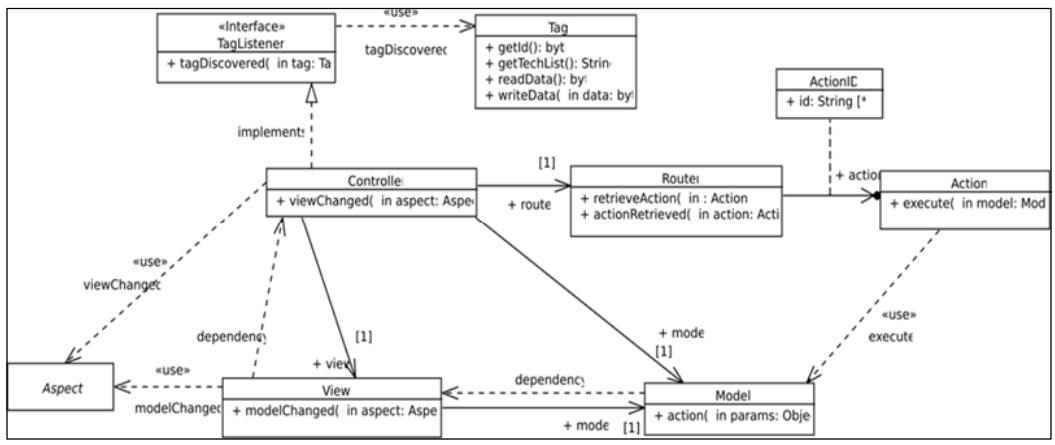
Figure 1. UML class diagram that depicts the software infrastructure required to support NFC